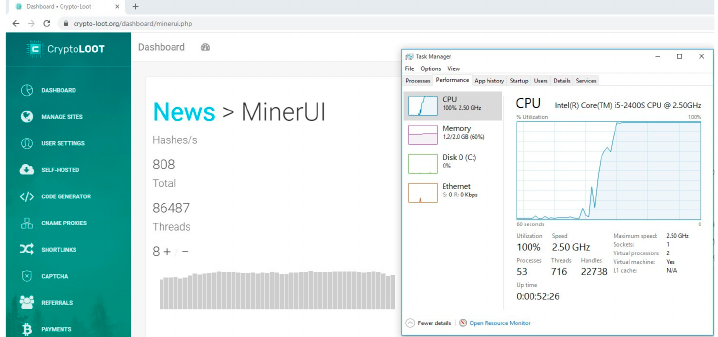
Figure 2. CPU usage when browsing a mining web page.